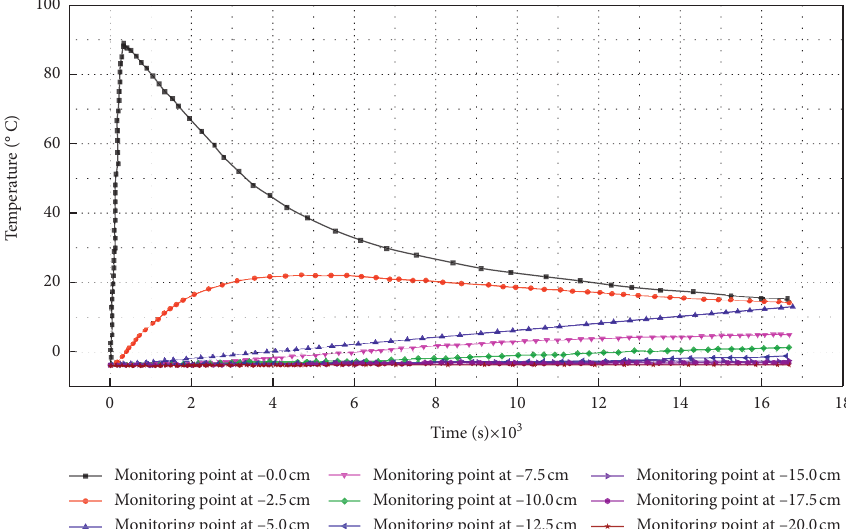
Figure 16: Temperature change over time at the monitoring points below the center of the frozen soil subgrade void